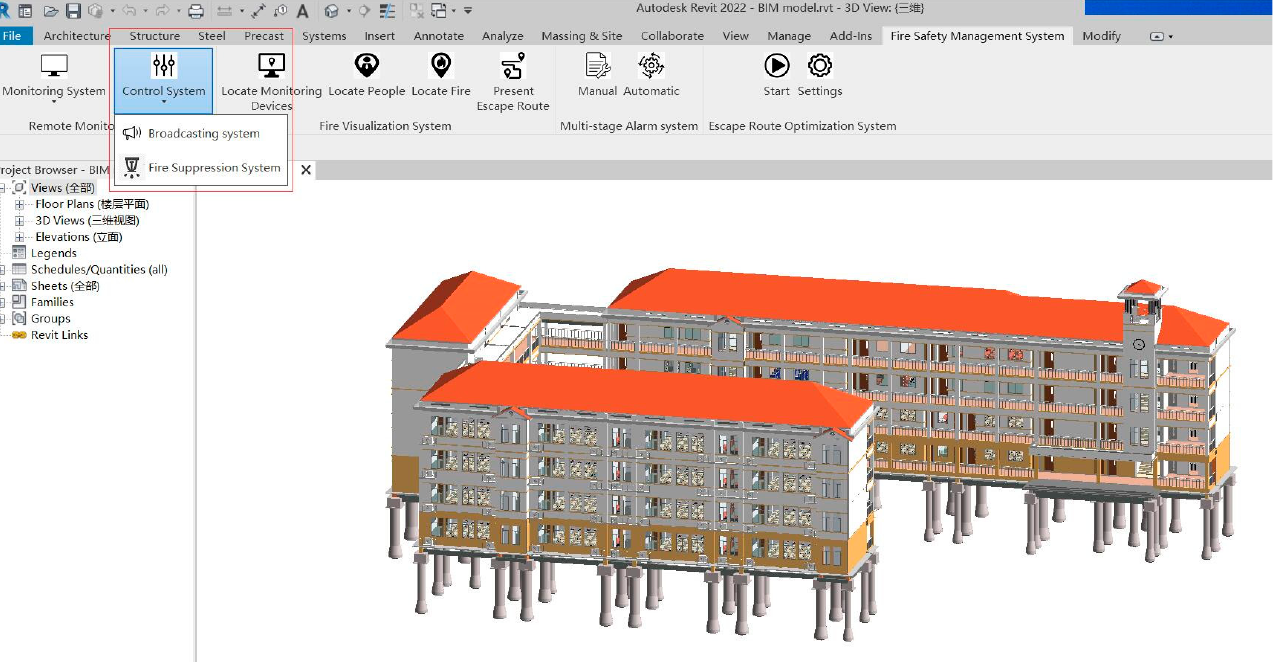
Figure 5. Example of components in the control system of the remote monitoring subsystem.